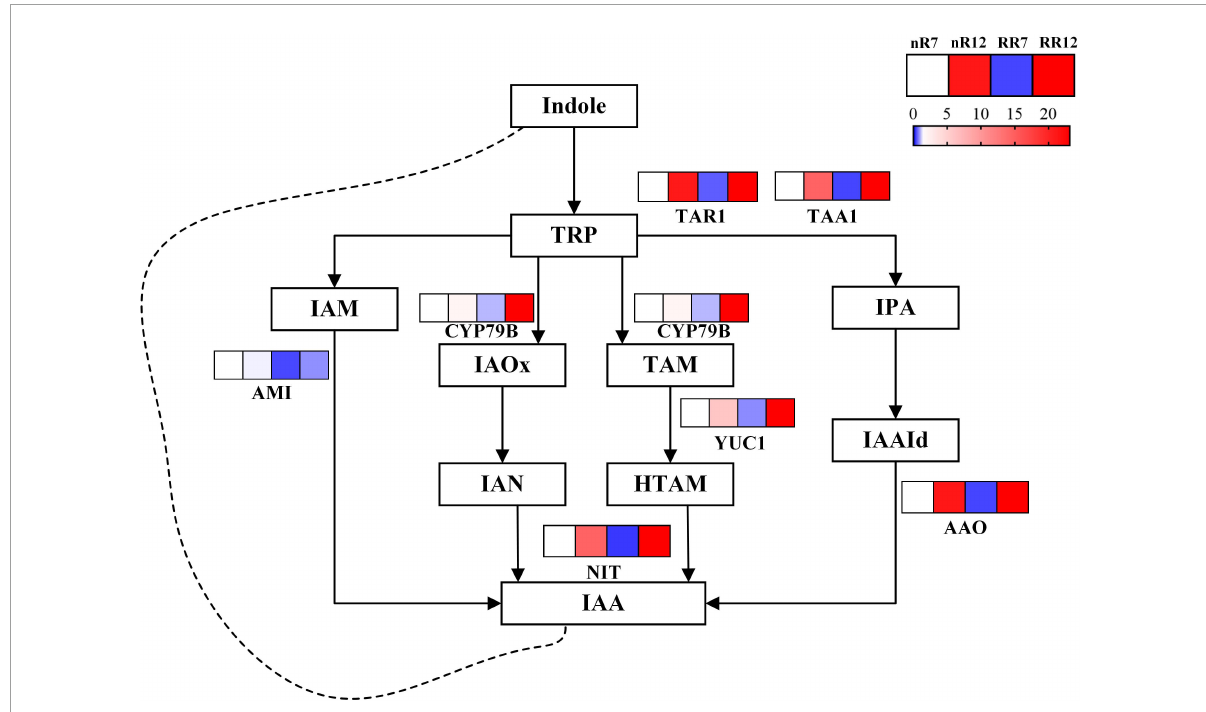
FIGURE10 Relative expression levels of genes in IAA biosynthesis and metabolism pathway. The expression levels of a total of 7 genes under different cultivation modes (nR and RR) and at different developmental stages (70 DAP and 125 DAP) are shown in heat maps, with red representing up-regulation and blue representing